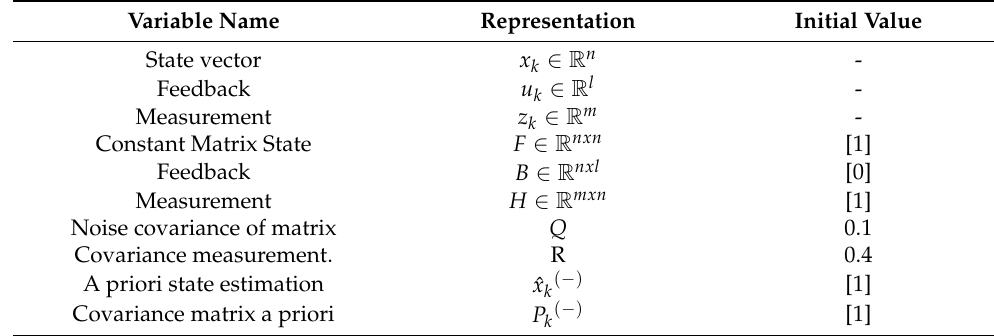
Table 1. Kalman Filter variables and initial